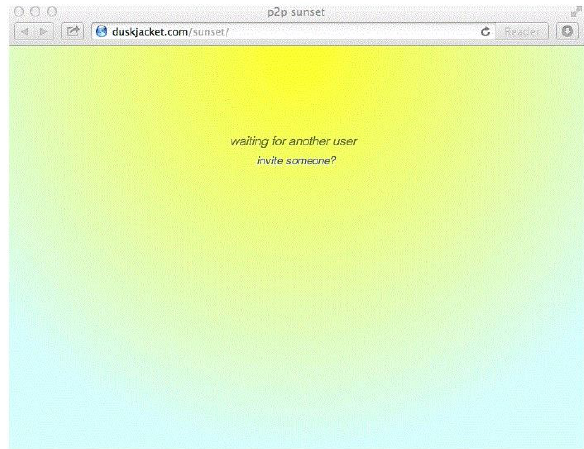
Figure 5 | Mark Beasley, Peer to Peer Sunset (2013). Courtesy of the